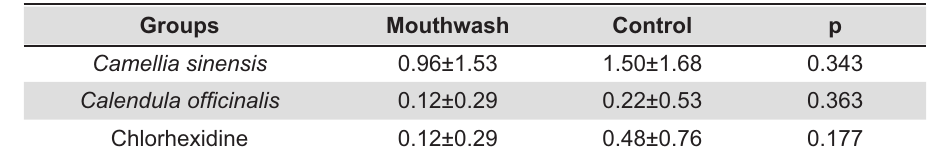
Table 3- Mean number and standard deviation of colony-forming units (CFU)/mL (log suture materials and grown on MacConkey agar obtained for the control groups and groups using Camellia sinensis